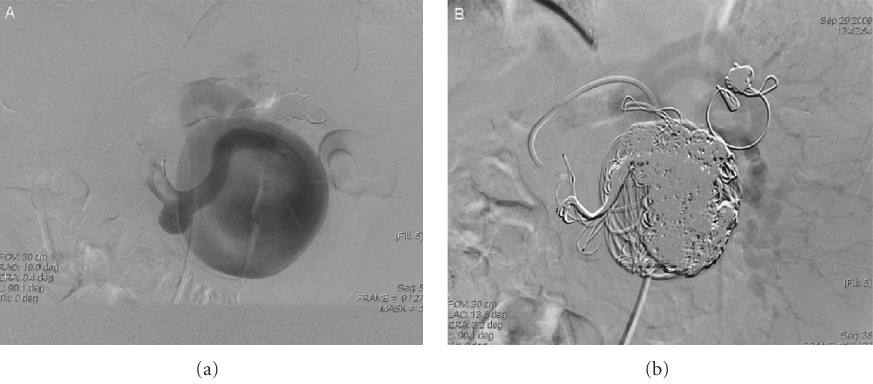
Figure 2: The placement of 11 guidewires and 75 coils within the aneurysmal